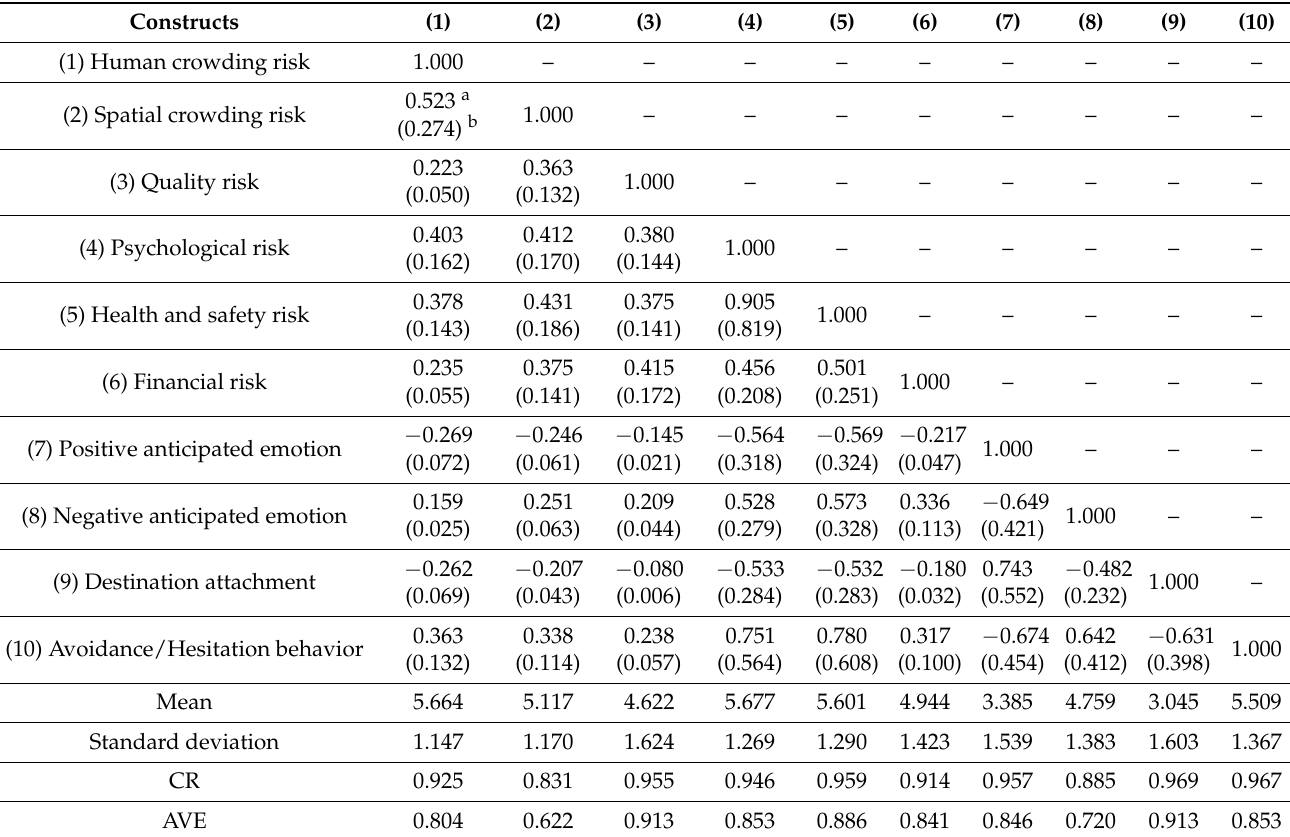
Table 1. Measurement model and data quality assessment results ( n =